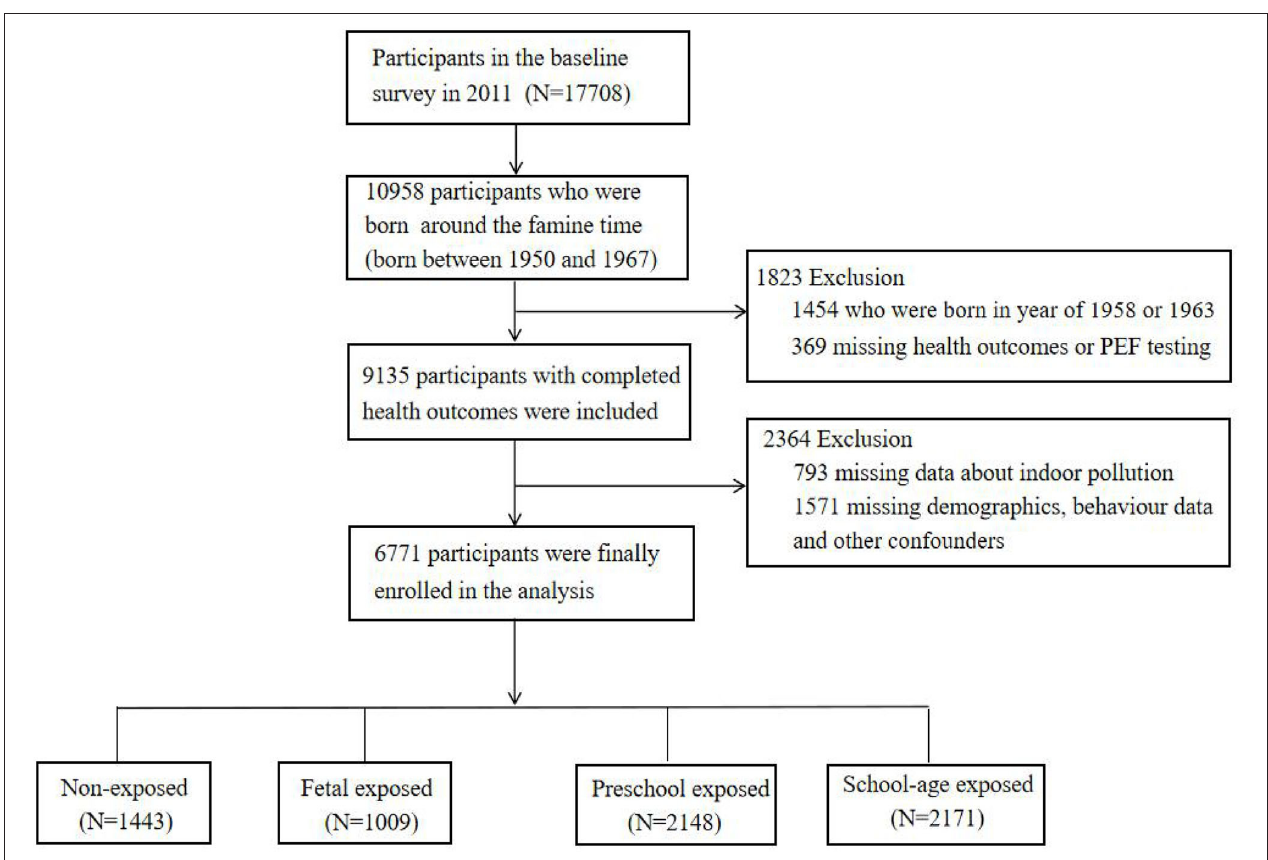
FIGURE 1 | Flowchart of the participants